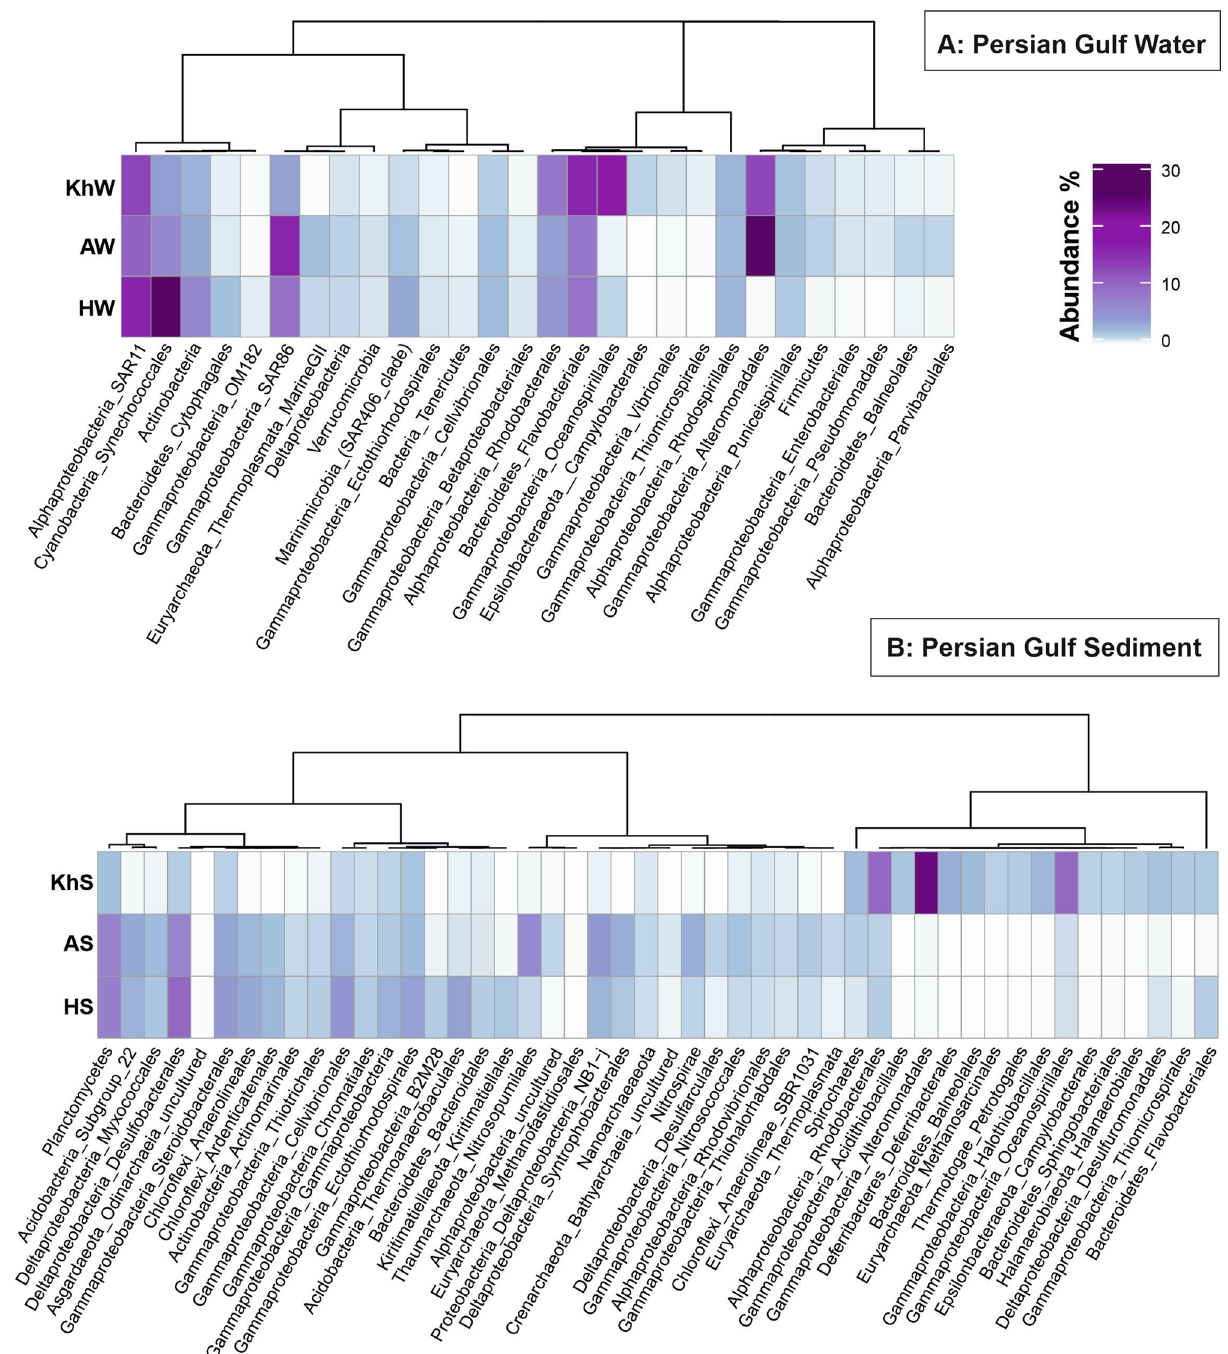
Figure 2. Prokaryotic community composition of the Persian Gulf water ( A ) and sediment ( B ) samples according to the abundance of 16S rDNA reads in unassembled metagenomes. Column names are microbial taxa at the order level. For some taxa with lower frequency, the sum of orders is displayed in their corresponding higher taxonomic level. There are a total number of 28 and 48 taxa for water and sediment samples, respectively by which samples are compared. Rows are the name of samples. Dendrograms represent the clustering of columns based on Pearson correlation. Figure was plotted using “circlize” and “ComplexHeatmap” packages in